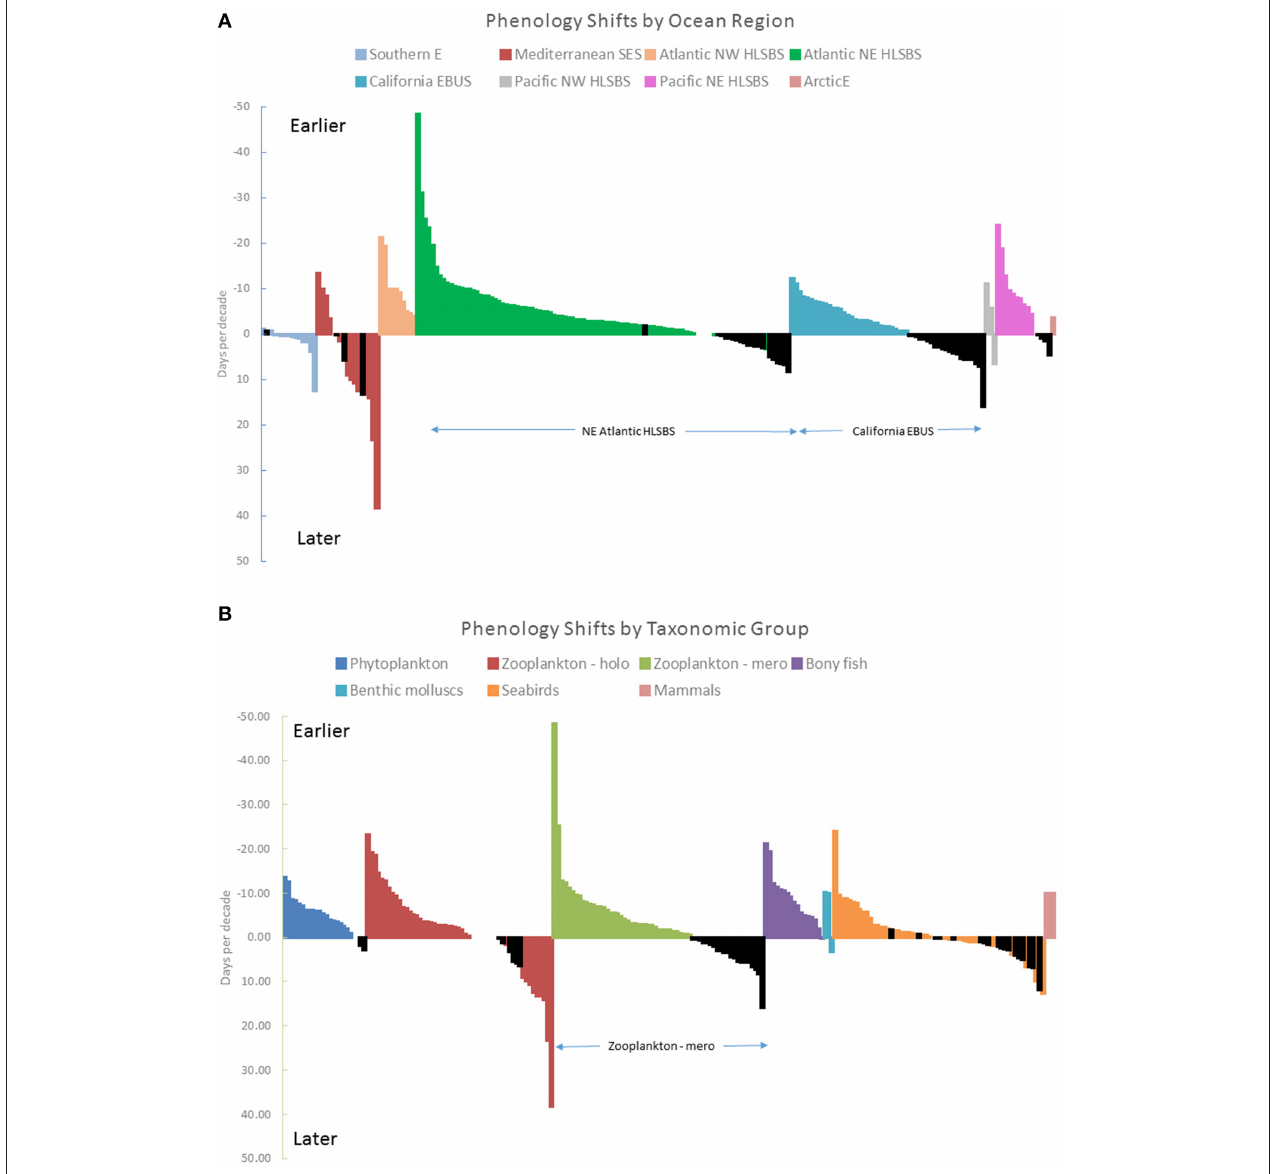
FIGURE 3 | Observed shifts phenology (days per decade) by (A) ocean regions and (B) taxonomic groups. Data from Poloczanska et al. (2013) and updated with recent literature (2011–2015). Colored bars are consistent with expectations under climate change, black bars are equivocal, and zero values are no change. A description of ocean regions are given Figure 30-1 in Hoegh-Guldberg et al. (2014). Total number of observations = 257.